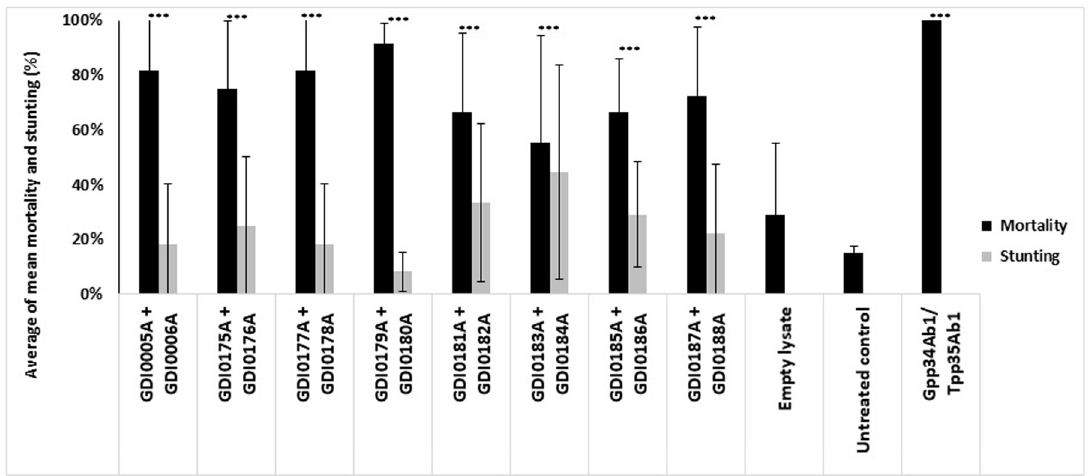
Fig 6. Activity of different pairs of GDI0005A/GDI0006A proteins, produced in E . coli on WCR susceptible neonates 5 days after treatment and infestation using a diet overlay bioassay. Different GDI0005A and GDI0006A homologs are compared. Activity was evaluated by assessing the percentage of mortality (black boxes) and the percentage of stunting (grey boxes). Each WCR larvae was exposed to ~200 μ L of WCR artificial diet overlaid with 20 μ L of bacterial lysate mixtures containing (GDI0005A + GDI0006A) or (GDI0005A homologs + GDI0006A homologs). Negative controls were lysates from E . coli bacteria transfected with the empty expression plasmid (empty lysate) and sterilized water (untreated control). The positive control was a lysate from bacteria transfected with a plasmid expressing the commercial Gpp34Ab1/Tpp35Ab1 binary proteins. Each experiment consisted of at least six 96-well plates each with 8 wells per treatment, totaling a sample size of 48 per treatment per experiment. A Fisher exact test was used to compare treatment results to the empty lysate at significance levels of P < 0.05 � , < 0.005 �� , < 0.001 ��� . The untreated control was only used to evaluate the quality and reliability of each bioassay. The error bars show the standard error of the mean (SEM).